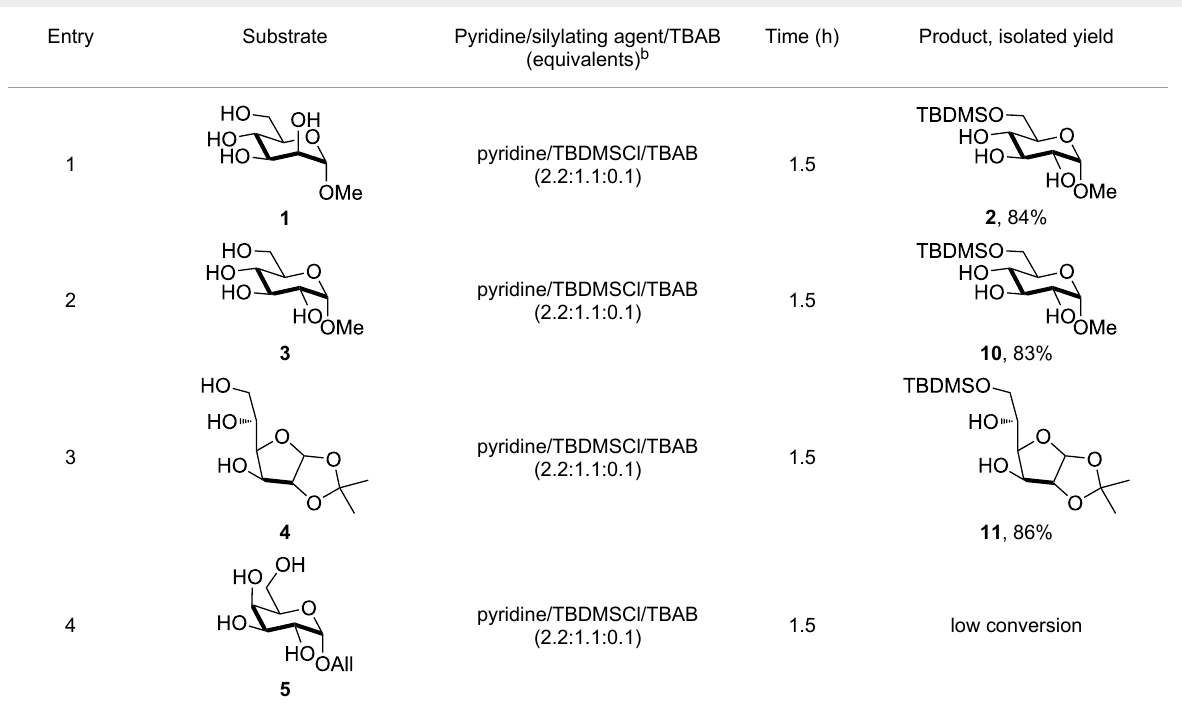
Table 2: Regioselective silylation of saccharide primary alcohols under solvent-free conditions a . Entry Substrate Pyridine/silylating agent/TBAB